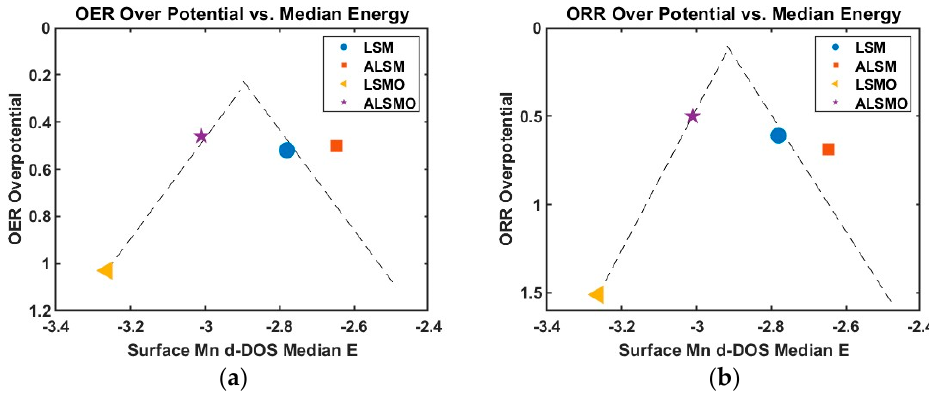
Figure 2. Plot of overpotentials (eV) vs. Mn d ‒ DOS median energy (eV) of LSM, ALSM, LSMO, and ALSMO structures for ( a ) OER and ( b )